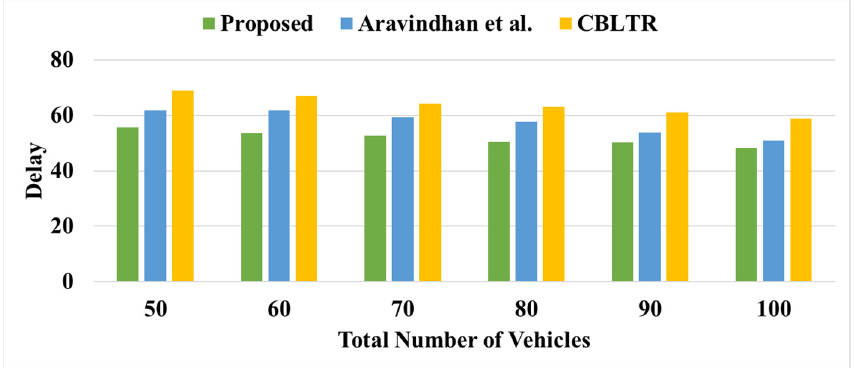
Figure 9. Comparison of results of the proposed system and existing systems (Aravindhan et al. [24] and CBLTR [21]) on delay versus vehicular nodes in area 1000 × 1000.